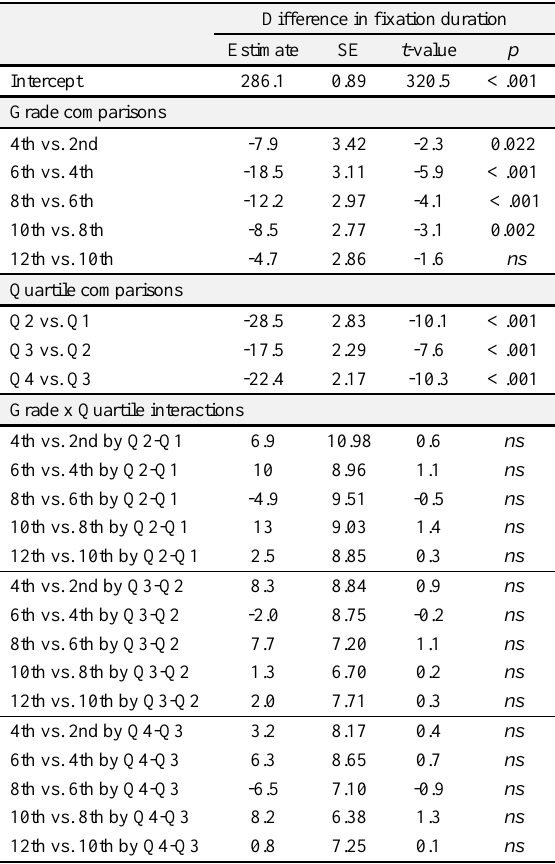
Table 6. Differences in Fixation Duration Between Grades and Reading Rate